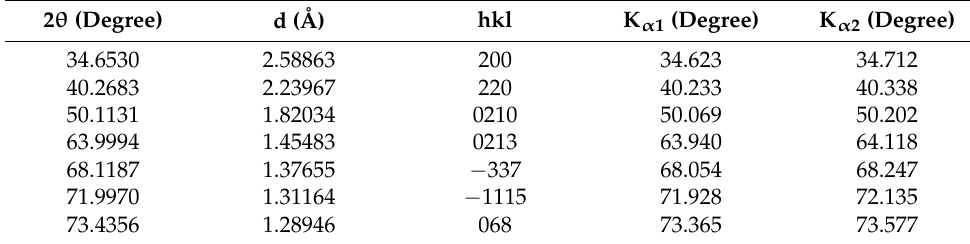
Table A3. K a1 and K a2 peaks for the reflections of the product.